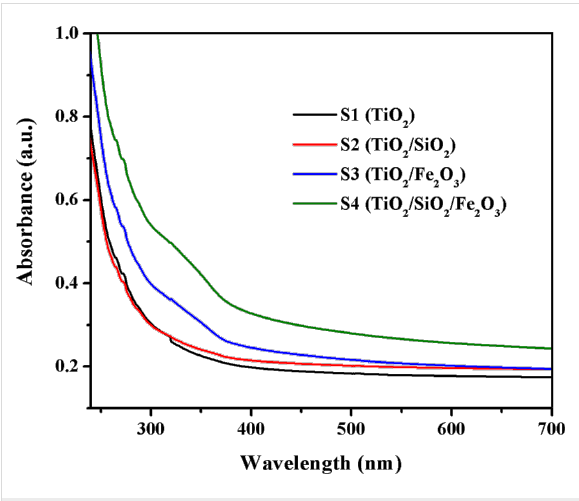
Figure 5: UV–vis absorption spectra of hybrid polymeric films